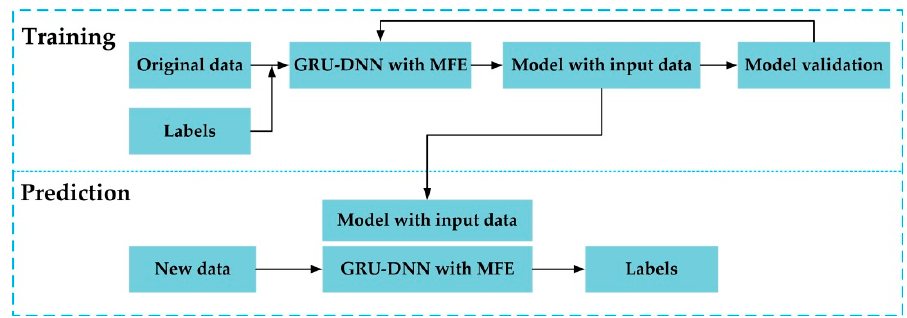
Figure 8. Training process of GRU-DNN with MFE.